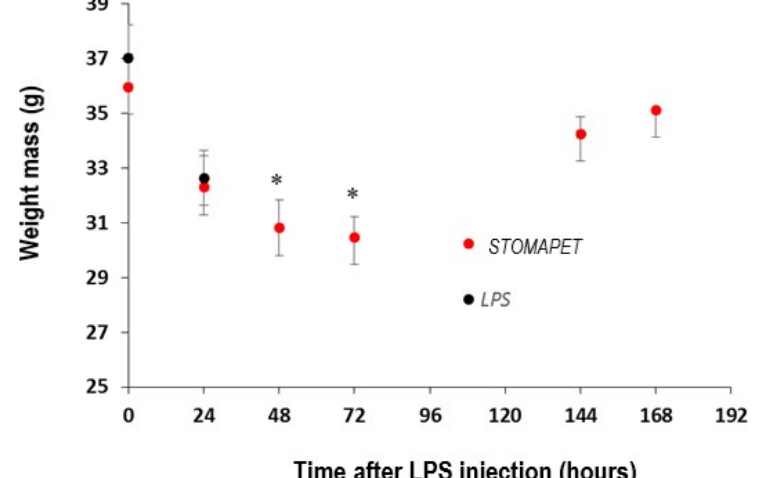
Figure 6. Mortality caused by LPS-induced endotoxemia is prevented by treatment with STOMAPET. Survival rate (%) analyzed according to the time (hours) elapsed since the intraperitoneal injection with LPS (20 mg/kg mouse mass). Group 1 (black line): n = 5 mice, Group 2 (red line): n = 5 mice.